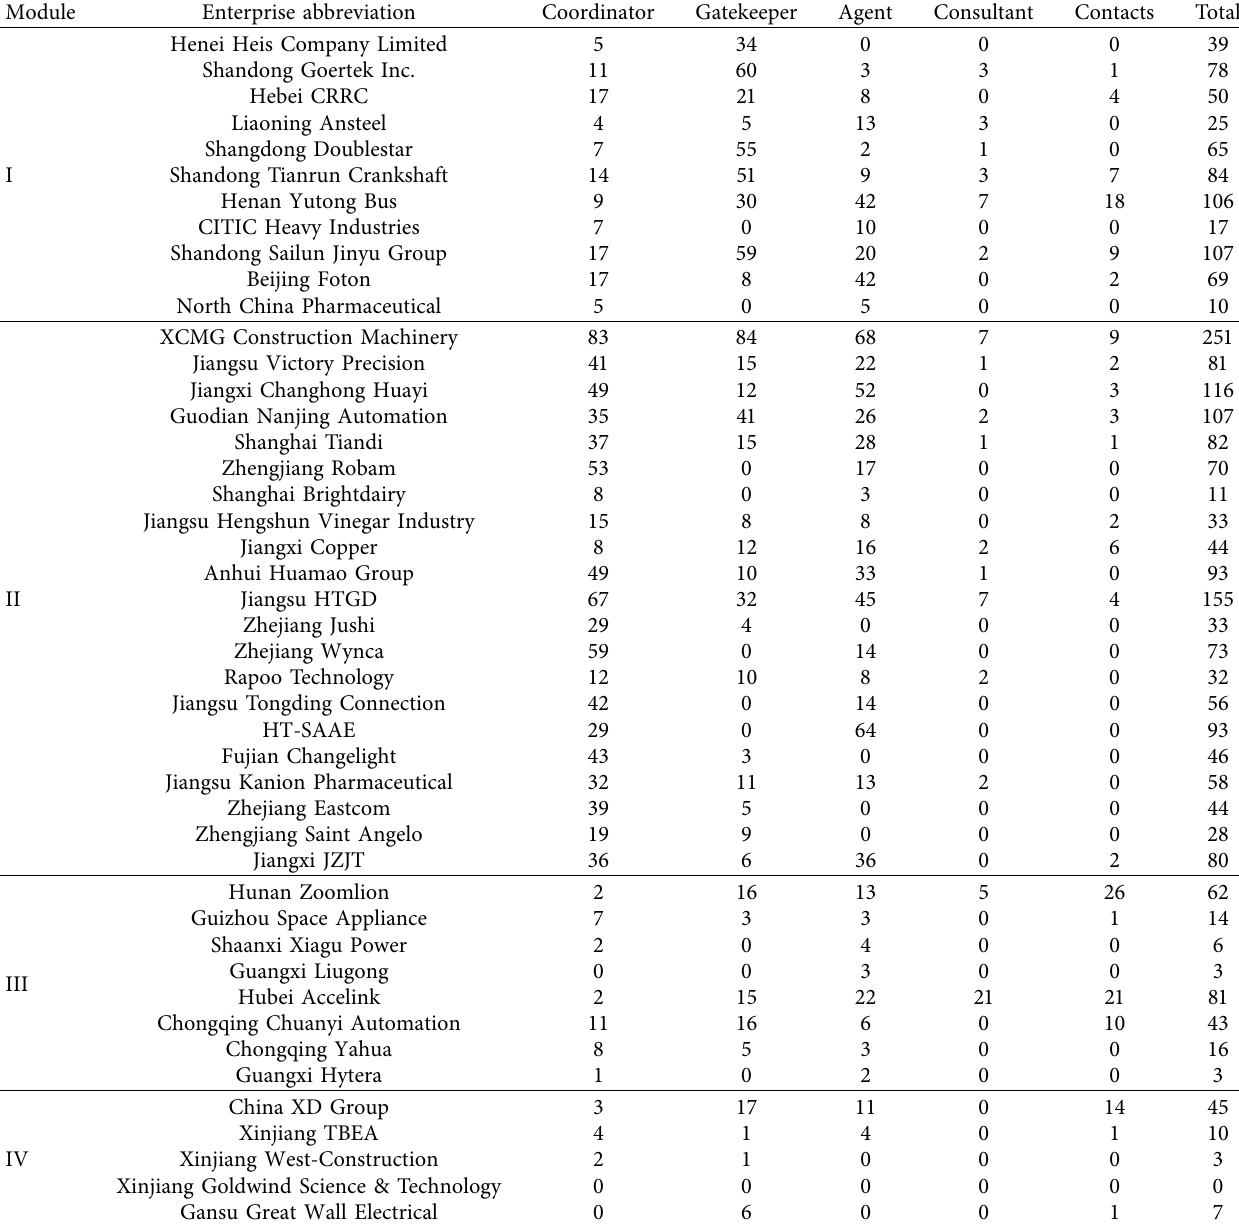
Table 7: Intermediary